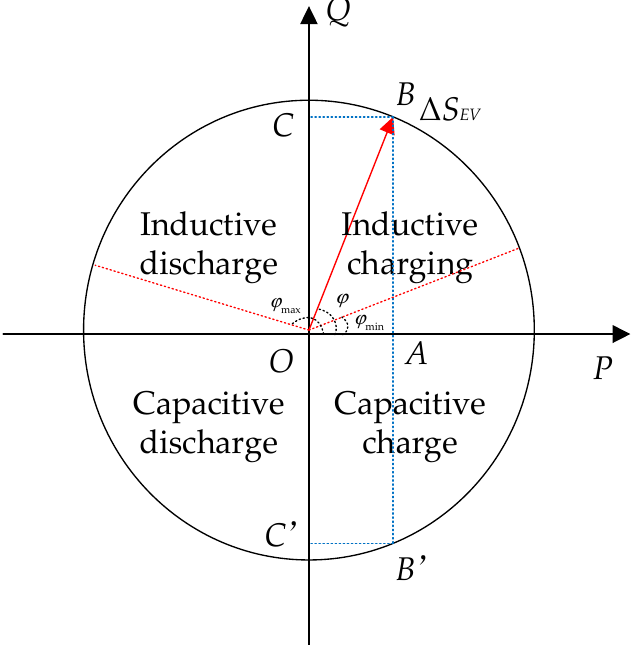
Figure 3. The capacity curve of the charger. φ is the power factor angle when the apparent rated power is Δ S EV . φ min and φ max are the minimum and maximum power factor angles of the charger. The positive axis of the P axis and Q axis represents the energy transferred from the grid to the EV charger. When